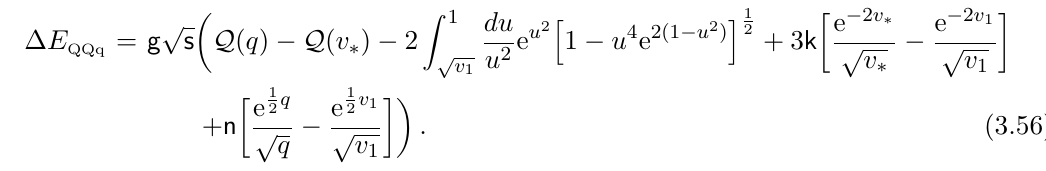
Figure 8 . Left: energies E In both cases k = − 1